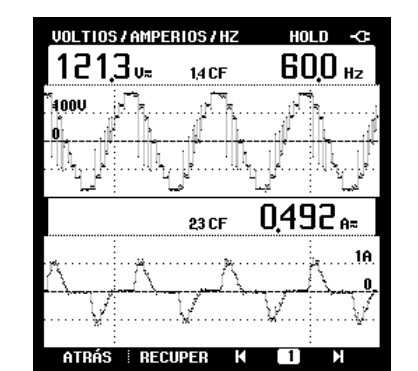
Figure 16: Waveforms Obtained by Fluke 43B Analyzer on Multilevel Inverter with Resistive Inductive Load.